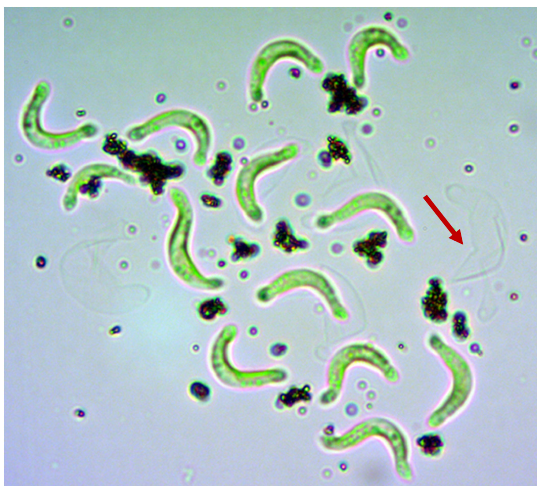
Figure 4. Transparent, algae-shaped structures (red arrow). This phase-contrast image (1000× magnification) was captured after 3 h incubation with 100 mg/L CeO 2 NM-213.